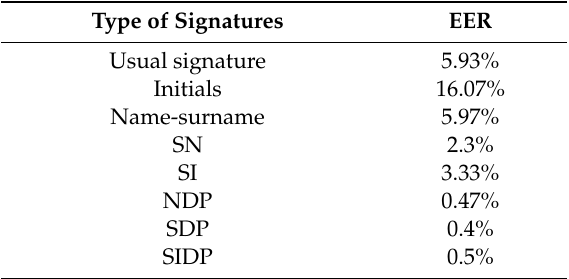
Table 5. System performance on users of the medium PE category in terms of